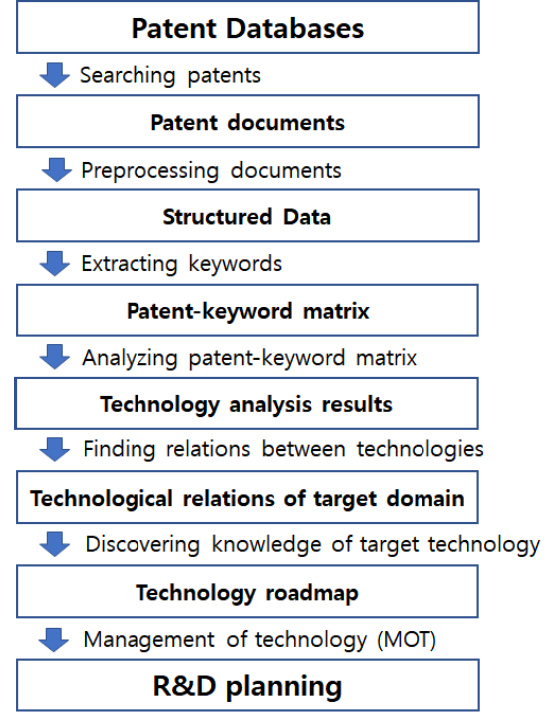
Figure 1. Process of patent data analysis.